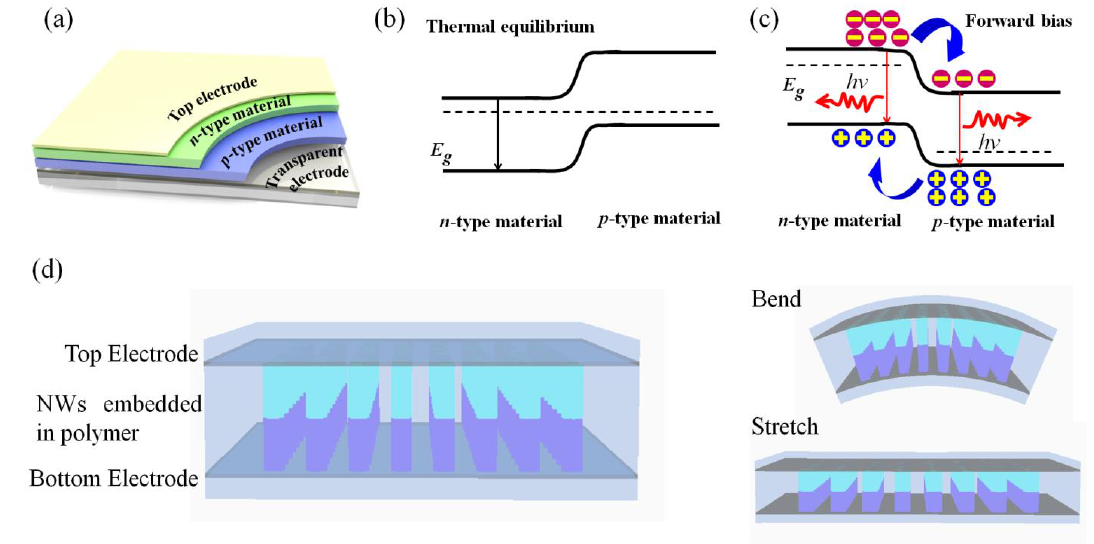
Figure 1: (a) A schematic showing the device configuration of an LED device. Energy band structures of the p − n junction (b) under thermal equilibrium and (c) under forward bias. (d) A schematic design in the stretchable LED device using p − n heterojunction nanowires (NWs) as the emissive materials. These devices are expected to possess excellent mechanical conformability and be able to comply with different deformations such as bending and stretching, as illustrated in the right